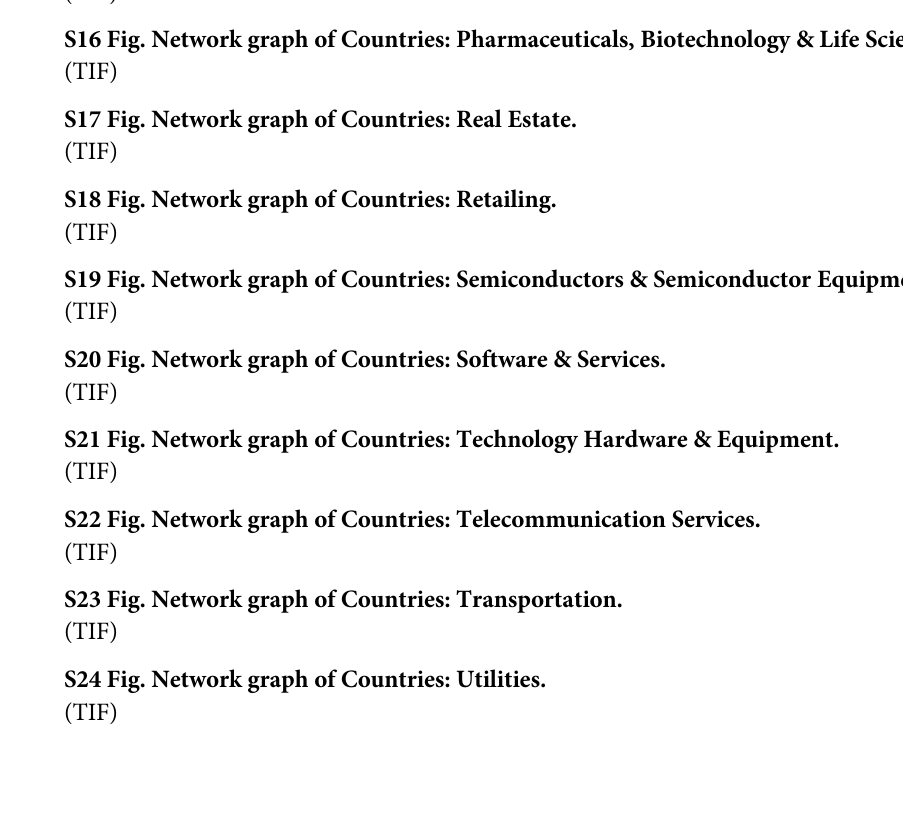
S6 Fig. Network graph of Countries: Consumer Services. (TIF) S7 Fig. Network graph of Countries: Diversified Financials. (TIF) S8 Fig. Network graph of Countries: Energy. (TIF) S9 Fig. Network graph of Countries: Food & Staples Retailing. (TIF) S10 Fig. Network graph of Countries: Food, Beverage & Tobacco. (TIF) S11 Fig. Network graph of Countries: Health Care Equipment & Services. (TIF) S12 Fig. Network graph of Countries: Household & Personal Products. (TIF) S13 Fig. Network graph of Countries: Insurance. (TIF) S14 Fig. Network graph of Countries: Materials. (TIF) S15 Fig. Network graph of Countries: Media. (TIF) S16 Fig. Network graph of Countries: Pharmaceuticals, Biotechnology & Life Sciences. (TIF) S17 Fig. Network graph of Countries: Real Estate. (TIF) S18 Fig. Network graph of Countries: Retailing. (TIF) S19 Fig. Network graph of Countries: Semiconductors & Semiconductor Equipment. (TIF) S20 Fig. Network graph of Countries: Software & Services. (TIF) S21 Fig. Network graph of Countries: Technology Hardware & Equipment. (TIF) S22 Fig. Network graph of Countries: Telecommunication Services. (TIF) S23 Fig. Network graph of Countries: Transportation. (TIF) S24 Fig. Network graph of Countries: Utilities.